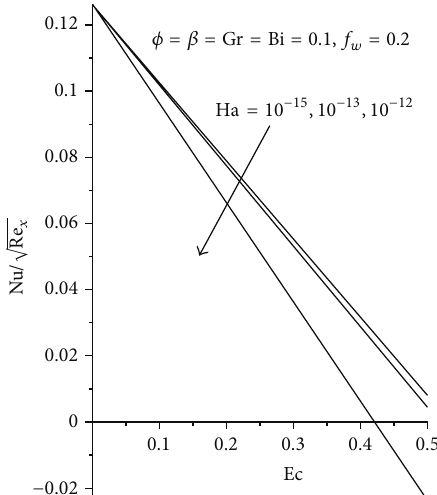
Figure 13: Effects of increasing 𝜑 , Ha, and Ec on local Nusselt